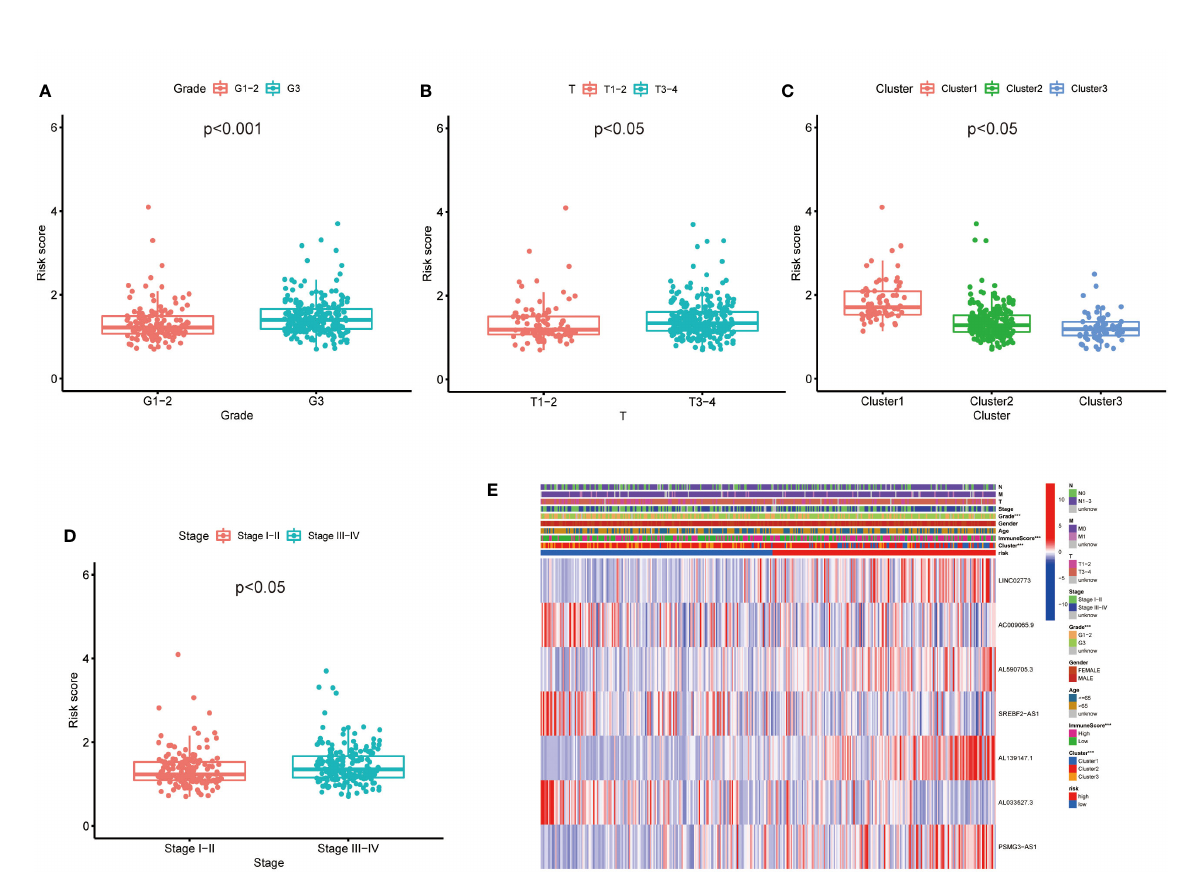
FIGURE 7 The prognostic risk model was applied to clinical features and immune characteristics of GC patients (A – D) Boxplot of relationship analysis of risk score and clinical features. (E) The clinicopathological differences between the high- and low-risk groups. ***p <